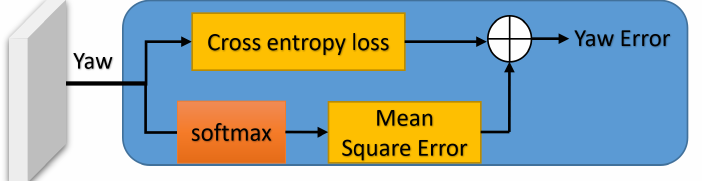
Figure 4. Combined loss. The symbols (cid:76) represents element-wise